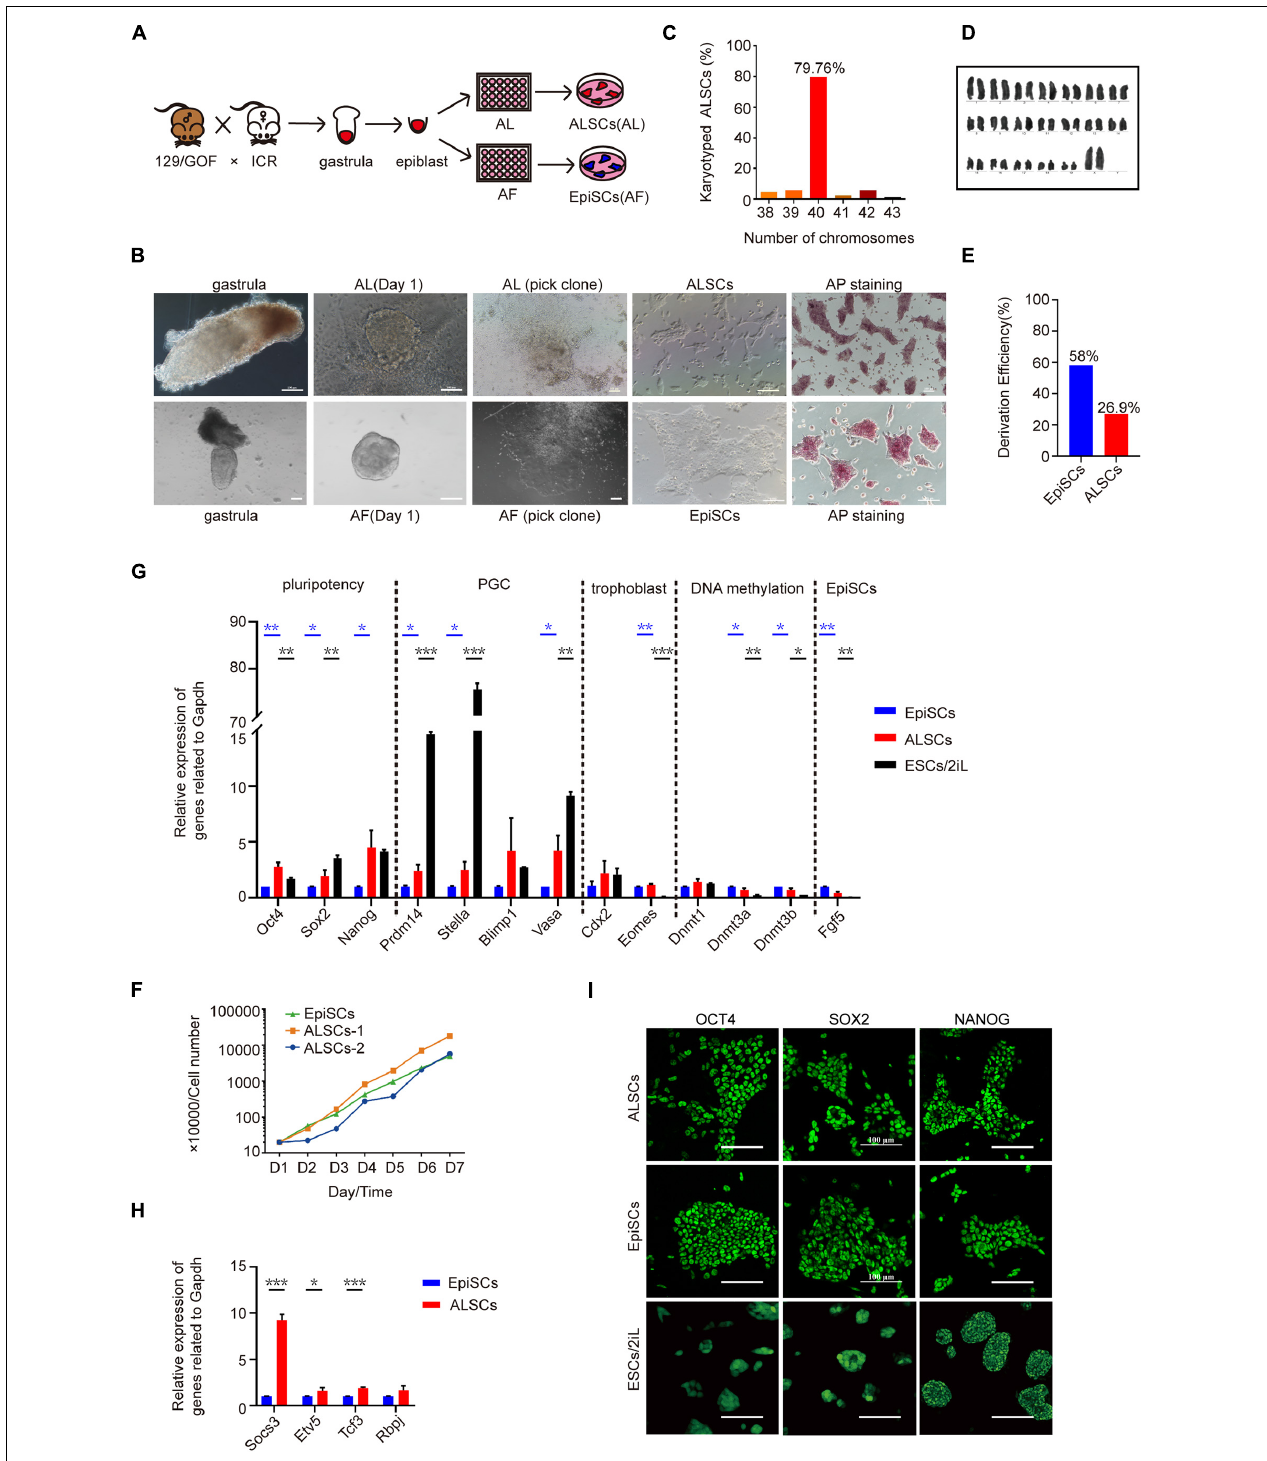
FIGURE 1 | Derivation and characterization of ALSCs. (A) Schematic of derivation of ALSCs. (B) Bright field image shows the derivation process and AP staining of ALSCs and EpiSCs. Scale bars, 100 µ m. (C) Distribution of chromosome numbers of ALSCs. (D) Karyotype of ALSCs. (E) Efficiency of ALSCs and EpiSCs both derived from gastrulas. (F) Cell growth curve of EpiSCs and ALSCs. (G,H) RT-qPCR of the key genes in ALSCs, EpiSCs, and ESCs/2iL. Error bars indicate three independent biological replicates (mean ± SD). *P < 0.05, * *P < 0.001, ** *P < 0.0001. (I) Immunostaining for pluripotent markers in ALSCs, EpiSCs, and ESCs/2iL. Scale bars, 100 µ